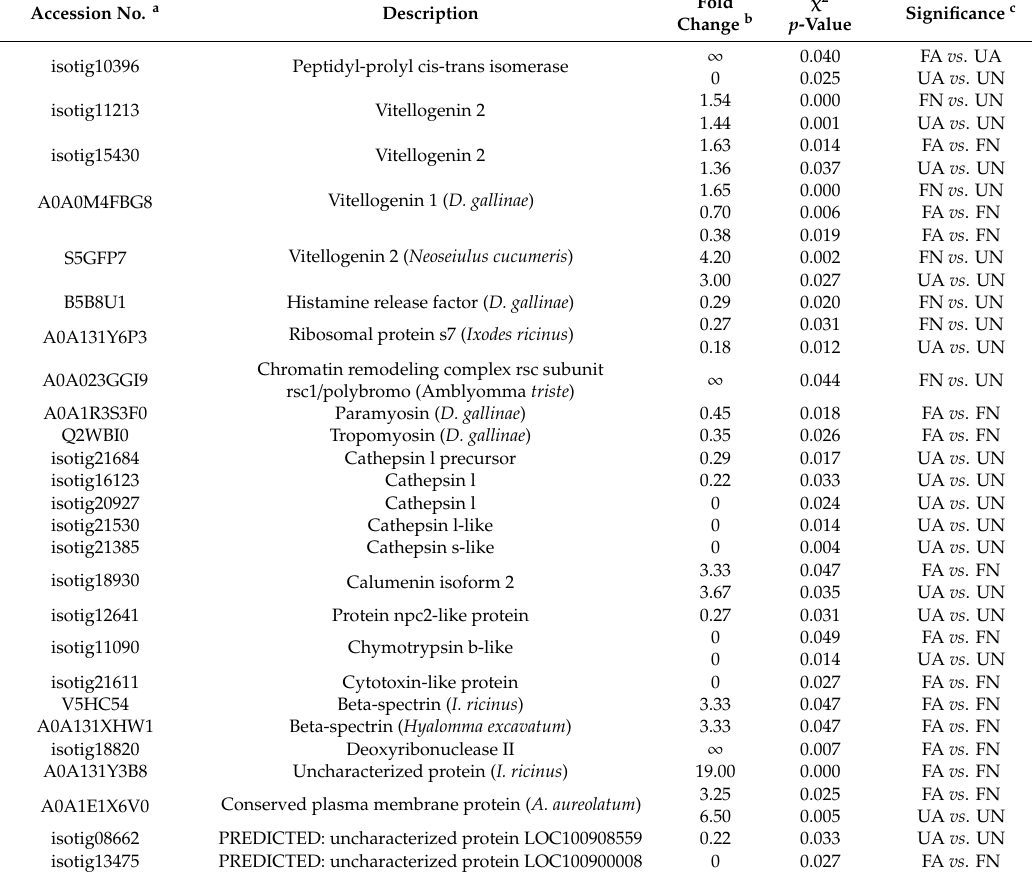
Table 1. Di ff erentially Represented Proteins Associated with Feeding and Developmental